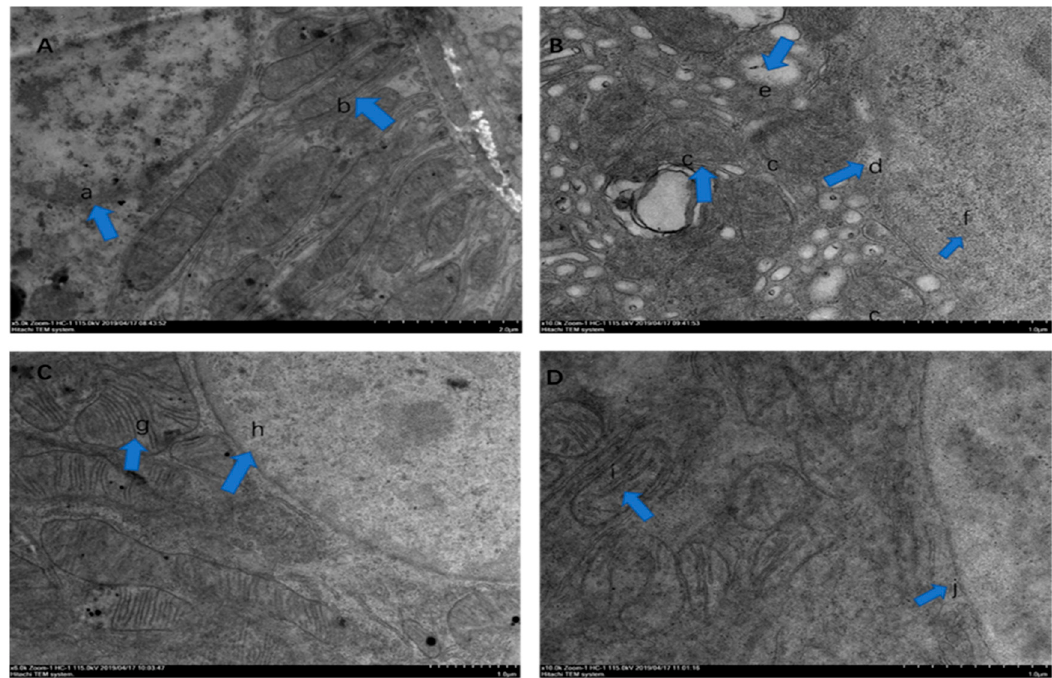
Figure 3. Electron microscopy observation. Renal electron micrographs of the control ( A ), OTA ( B ), ASX ( C ), ASX and OTA ( D ) groups. n = 6 mice/group.